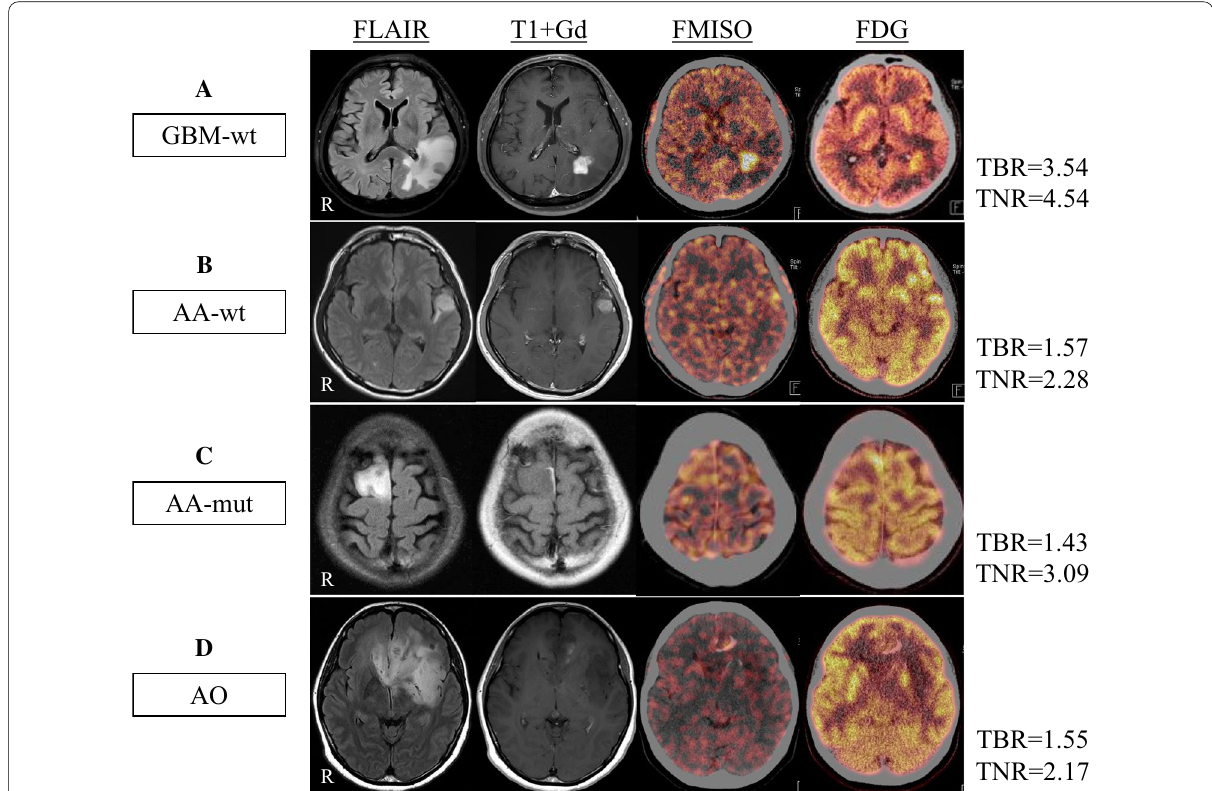
Fig. 3 MRI (FLAIR and T1 Gd) and PET images (FMISO and FDG) in representative glioma patients. a A 66-year-old male patient with GBM-wt + showing high uptake of FMISO (TBR 3.54) and FDG (TNR 4.54). b A 36-year-old male with AA-wt showing slightly increased uptake of FMISO = = (TBR 1.57) and FDG (TNR 2.28). c A 31-year-old female with AA-mut showing slightly increased uptake of FMISO (TBR = = FDG (TNR 3.09). d A 38-year-old female with AO showing slightly increased uptake of FMISO (TBR =